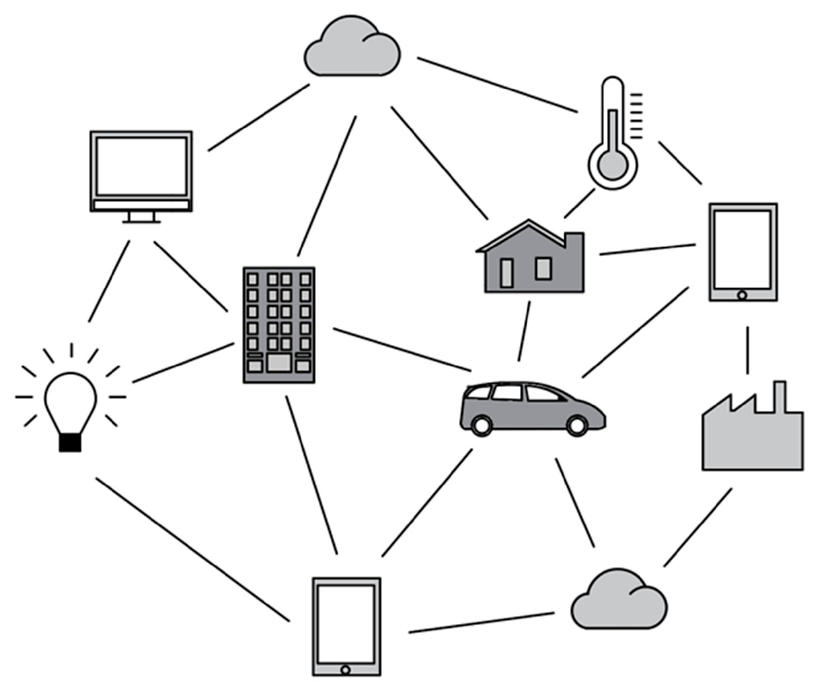
Figure 1. General IoT solution.